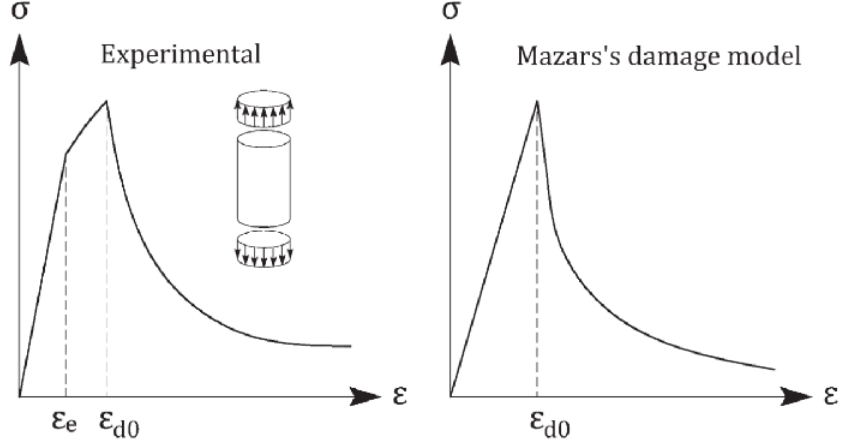
Constitutive concrete law during a tensile test (left) and Mazars’s damage model [19]